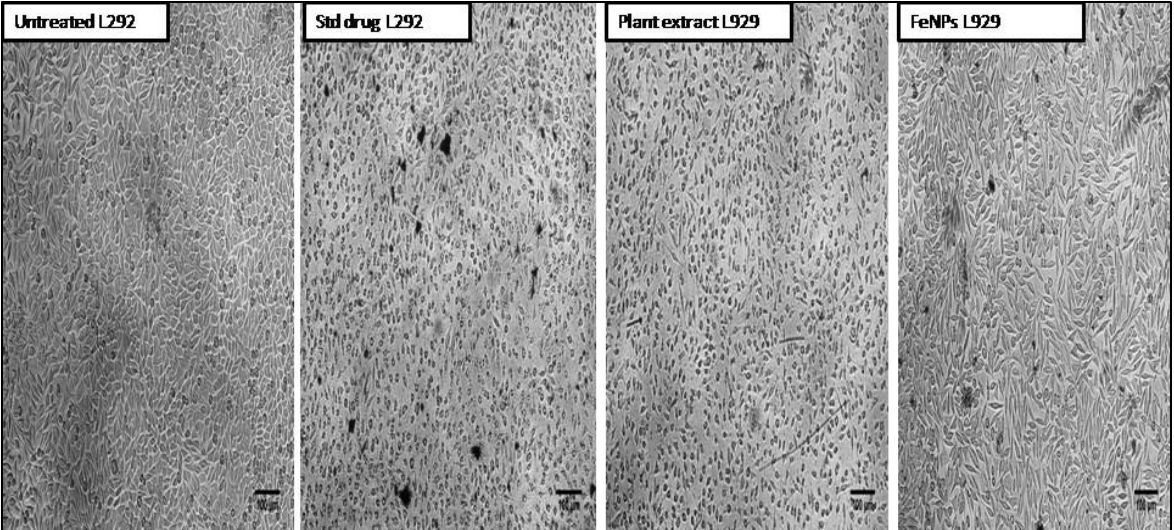
Figure 13. Morphological study of effect of aqueous leaf extract of V. leucoxylon and its synthesized iron nanoparticles against L929 cell line. The scale used is 100 µm.